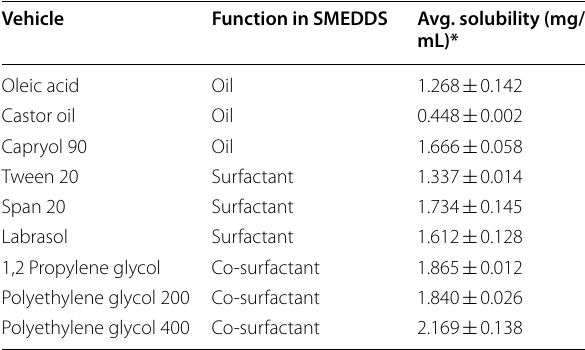
*Each value represents the mean